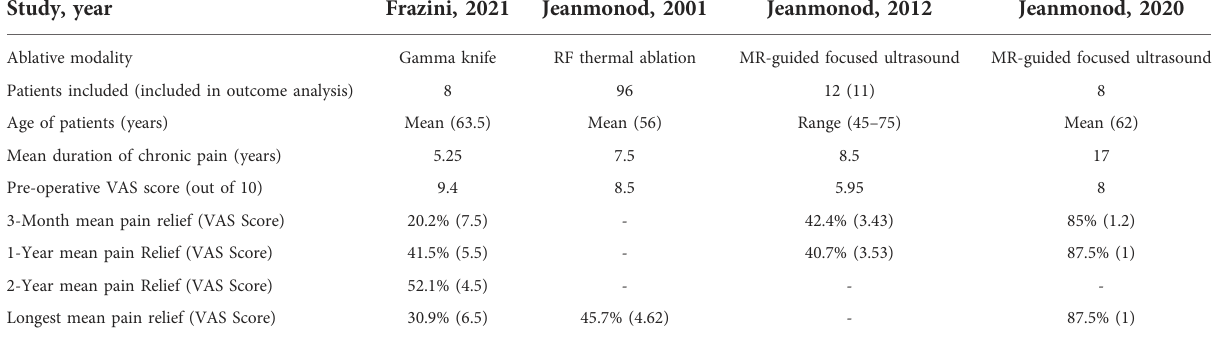
TABLE 1 Studies of neuroablative CLp thalamotomy for chronic neuropathic pain. Study,